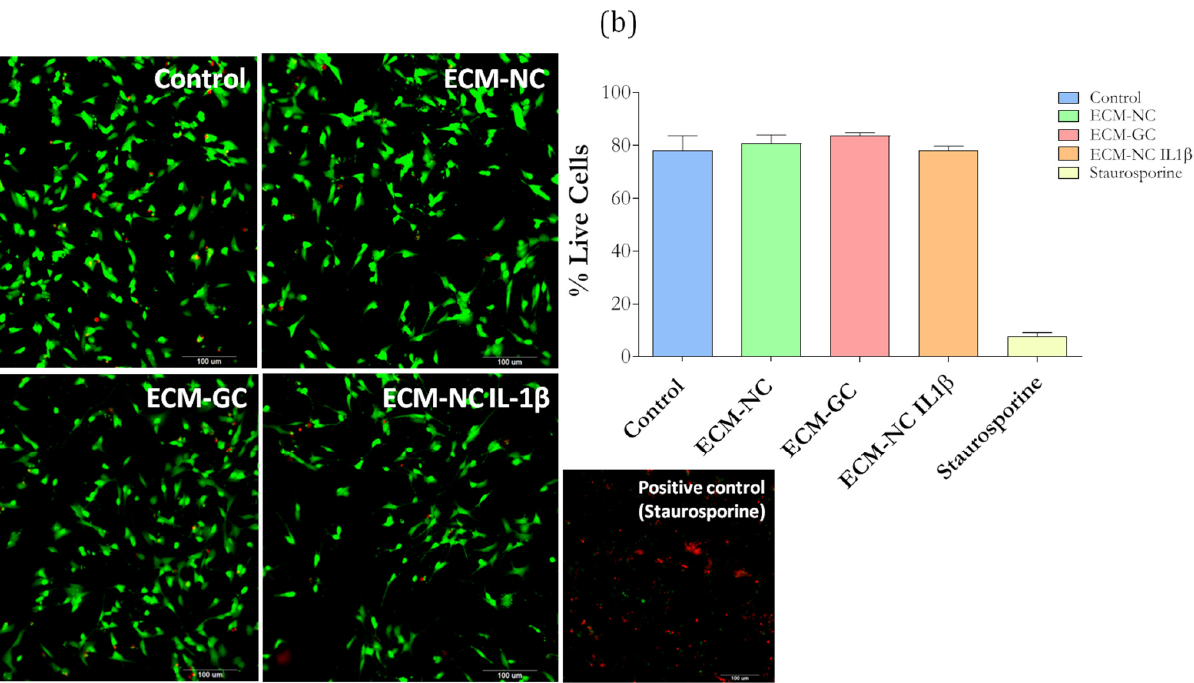
Figure 5. ( a ) Cell viability images show dead cells stained in red and live cells stained in green. Scale bar: 100 µm. ( b ) Cellular viability quantification (% of live cells) performed at 72 h. ECM-NC, ECM-GC, ECM-NC IL-1 β , and positive control (staurosporine, 5 µM). Three independent and similar assays were performed in triplicate. Data were analyzed by one-way ANOVA with post hoc testing by Dunnett p > 0.05).